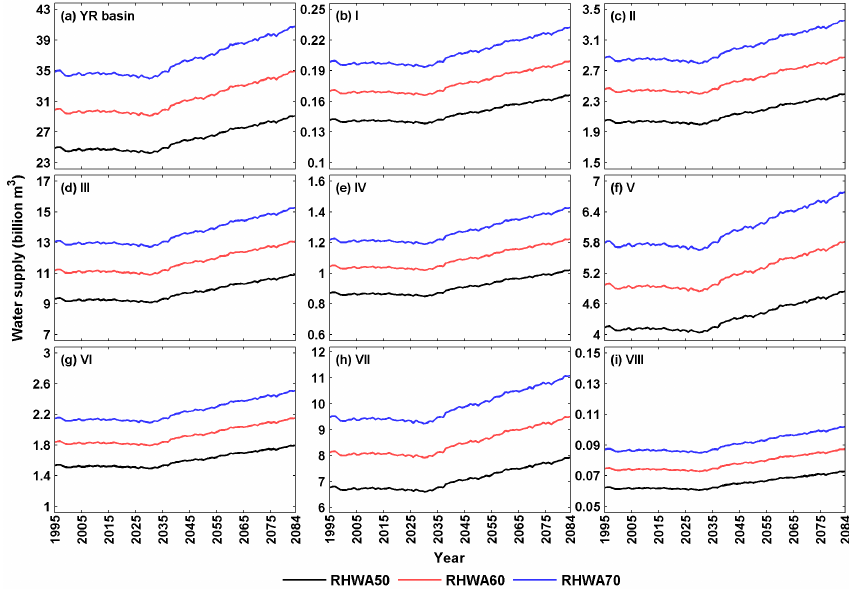
Figure 3. Annual water supplies in the YR basin and eight sub-basins during the 21st century. The water supply was estimated with RHWA values of 50, 60, and 70%,